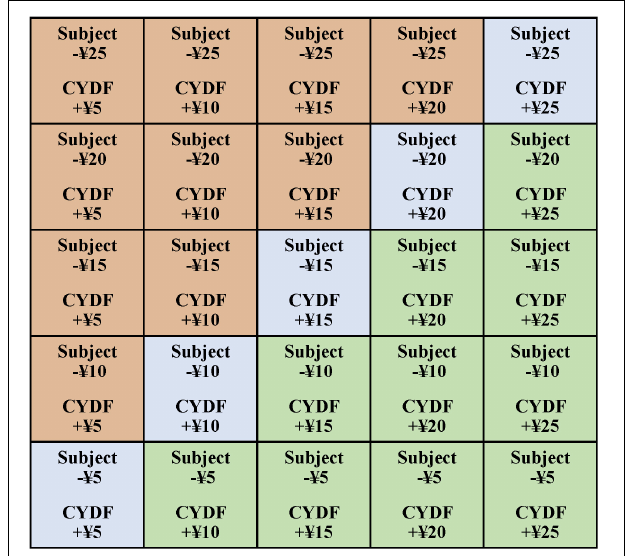
FIGURE 1 | Combinations of the amount of money the participant donated and the amount the charity